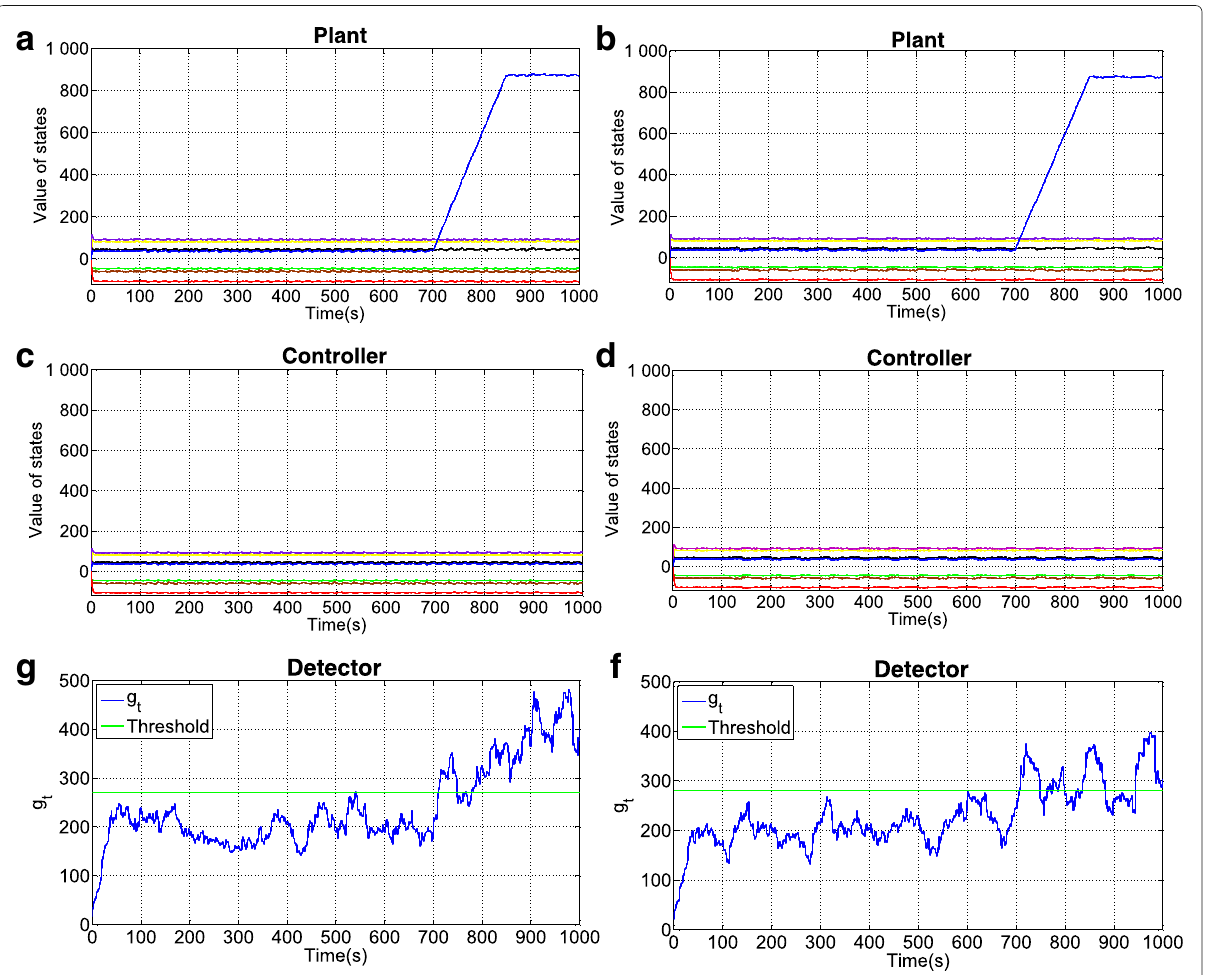
Fig. 5 Numeric simulation results. Attacks start at t = 700 s. a , b The dynamics of the states vector in the plant under a non-parametric cyber-physical adversary attack and switching frequency configured with two different configurations (0.14 and 0.05 Hz). c , d The dynamics of the states vector estimated in the controller, under the same scenarios. e , f The dynamics of the alarm signal g t produced by the multi-watermark-based detector, under the same scenarios. a Plant states under a non-parametric cyber-physical adversary attack and switching frequency set to 0.14 Hz, i.e., every 7 timesteps, the controller changes the distribution associated with the watermark. b Plant states under a non-parametric cyber-physical adversary attack and switching frequency set to 0.05 Hz, i.e., every 20 timesteps, the controller changes the distribution associated with the watermark. c Estimated states in the controller under a non-parametric cyber-physical adversary attack and switching frequency set to 0.14 Hz. d Estimated states in the controller under a non-parametric cyber-physical adversary attack and switching frequency set to 0.05 Hz. e Detector results, switching frequency set to 0.14 Hz. f Detector results, switching frequency set to 0.05